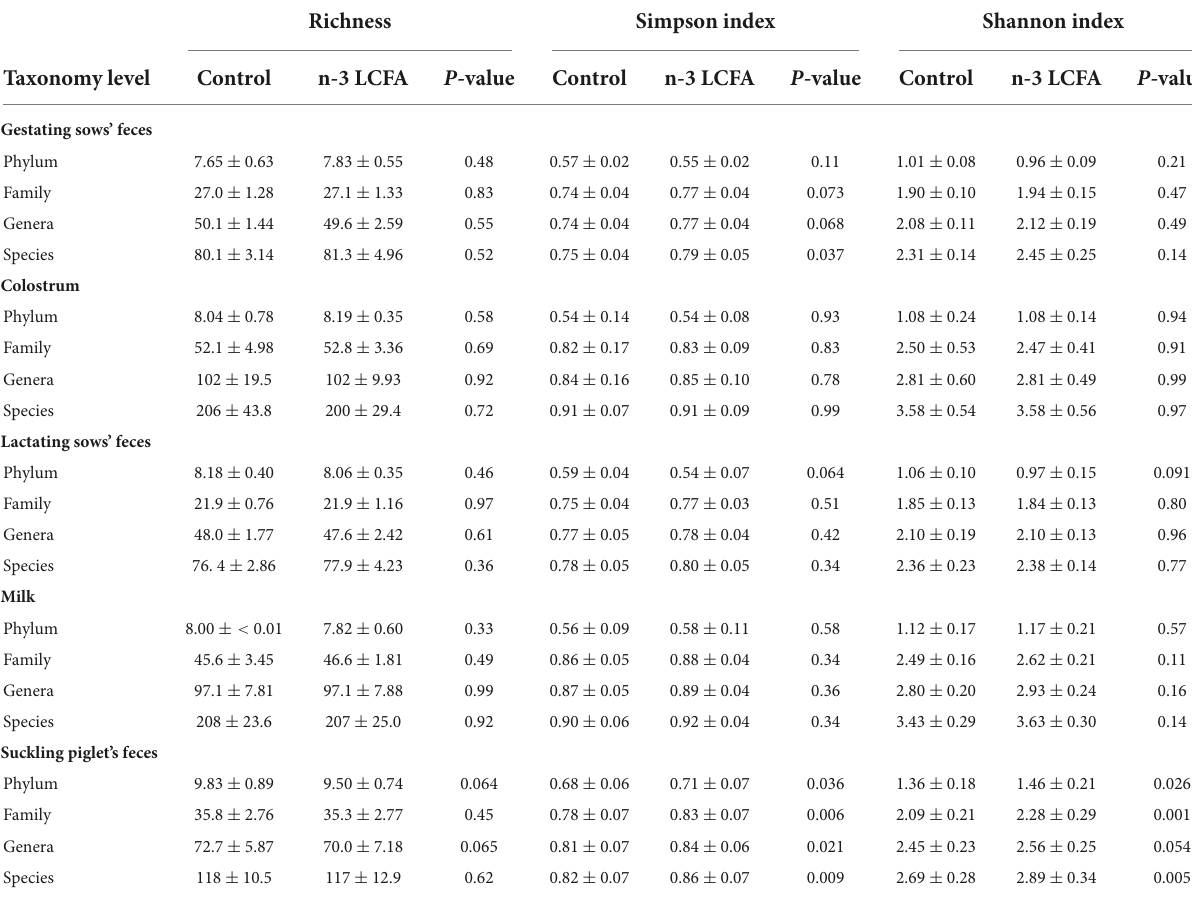
TABLE 1 Microbiota alpha diversity indices, calculated at phylum, family, genera, and species level, of feces of gestating and lactating sows, colostrum, milk, and feces of suckling piglets from animals fed either control or n-3 LCFA diets.